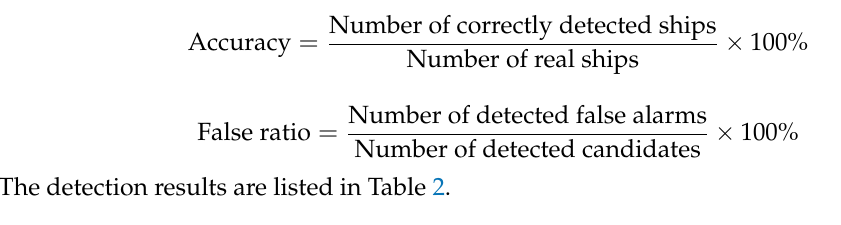
Table 2. Target detection results in terms of the accuracy and the false